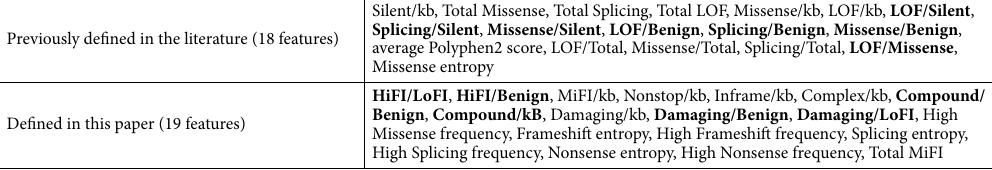
Previously defined in the literature (18 features)